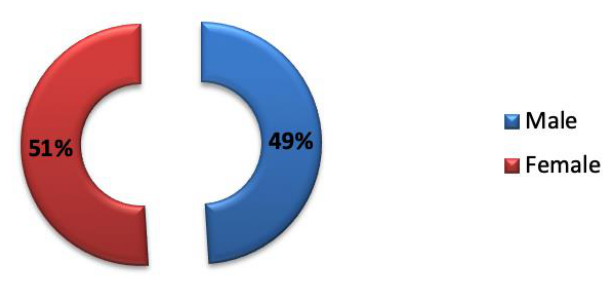
Figure 4: Gender diversity of respondents